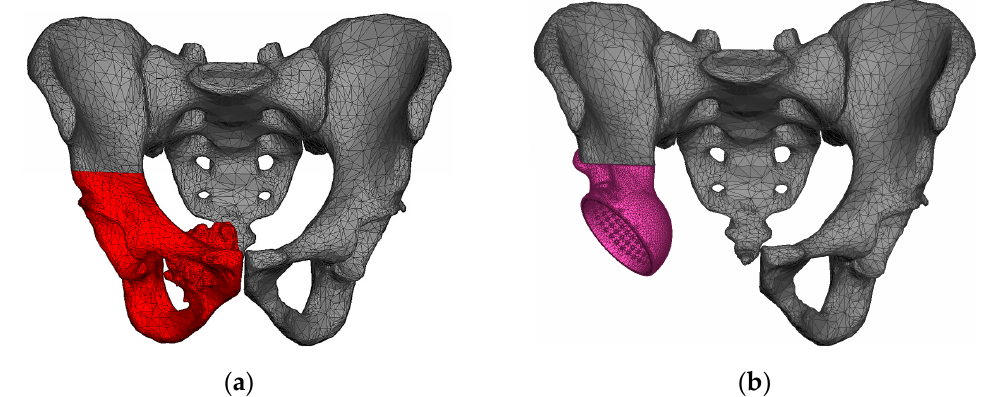
Figure 6. Surface model of pelvis obtained by computer tomography: ( a ) before surgery; ( b ) after